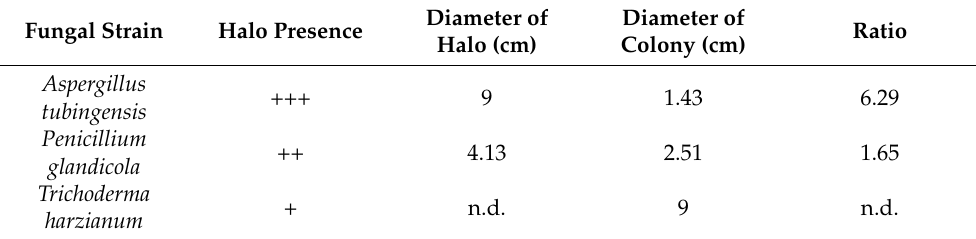
Figure 1. CAS agar test result: A. tubingensis ( a ) front and ( e ) reverse; P. glandicola ( b ) front and ( f ) reverse; T. harzianum ( c ) front and ( g ) reverse; CAS agar control ( d ) front and ( h ) reverse. Table 2. CAS agar test result of the strains tested: (+++) strong, (++) moderate, (+) weak, not detectable (n.d.) .